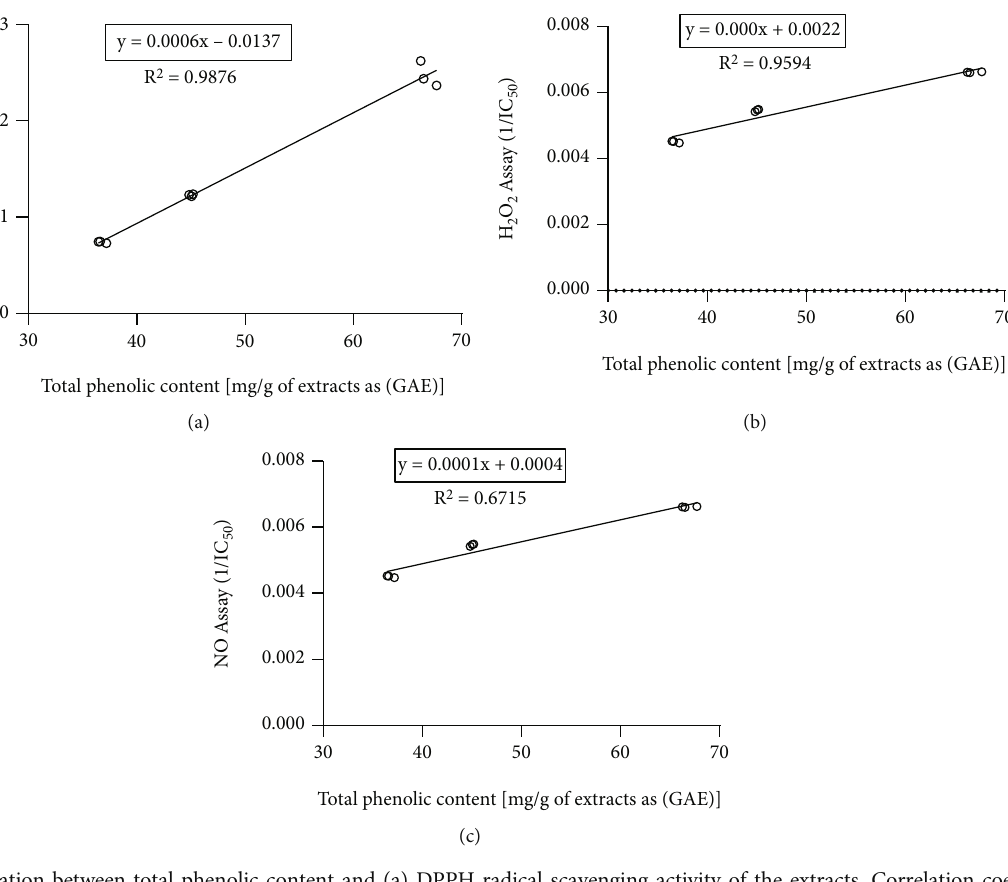
O radical scavenging activity of the extracts. Correlation coe ffi cient, r = 2 2